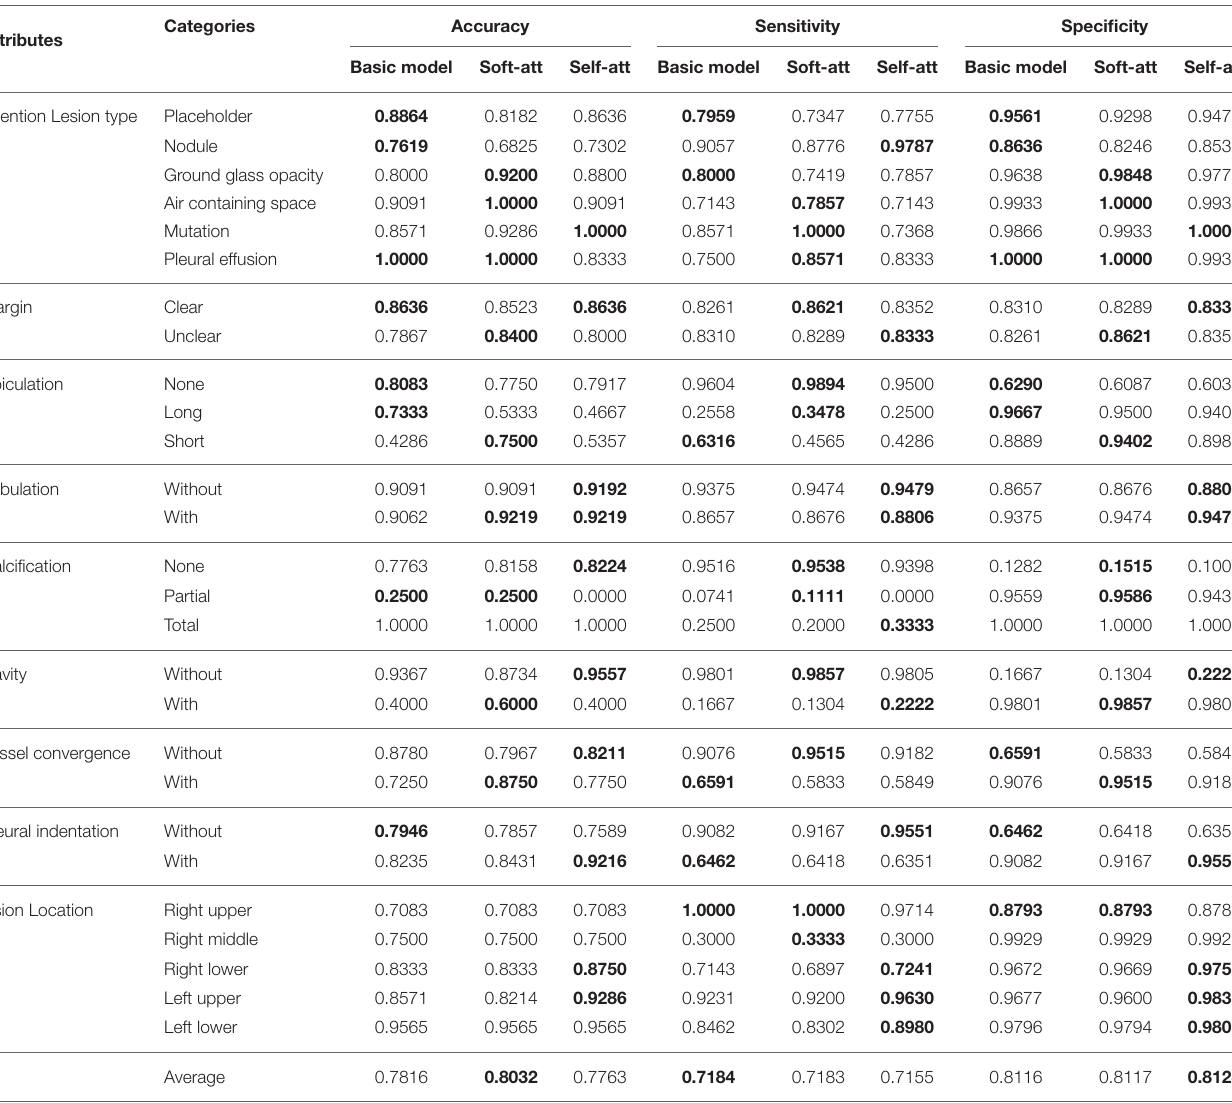
TABLE 4 | Performance of the basic, soft-attention, and self-attention models on the 2D mode.